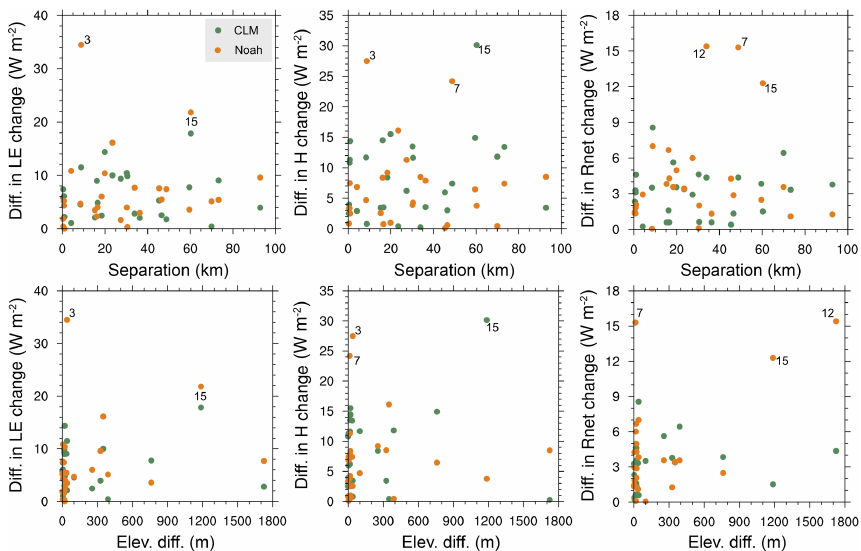
Figure 11. Sensitivity of differences in simulated surface energy flux changes (left column: LE, middle: H , and right: R net ) between “forest forcing” and “open forcing” simulations to site separation (top) and elevation difference (bottom) between the forest and open sites in individual pairs. The pair nos. 3, 7, 12, and 15 are labeled because of the greatest differences in surface flux